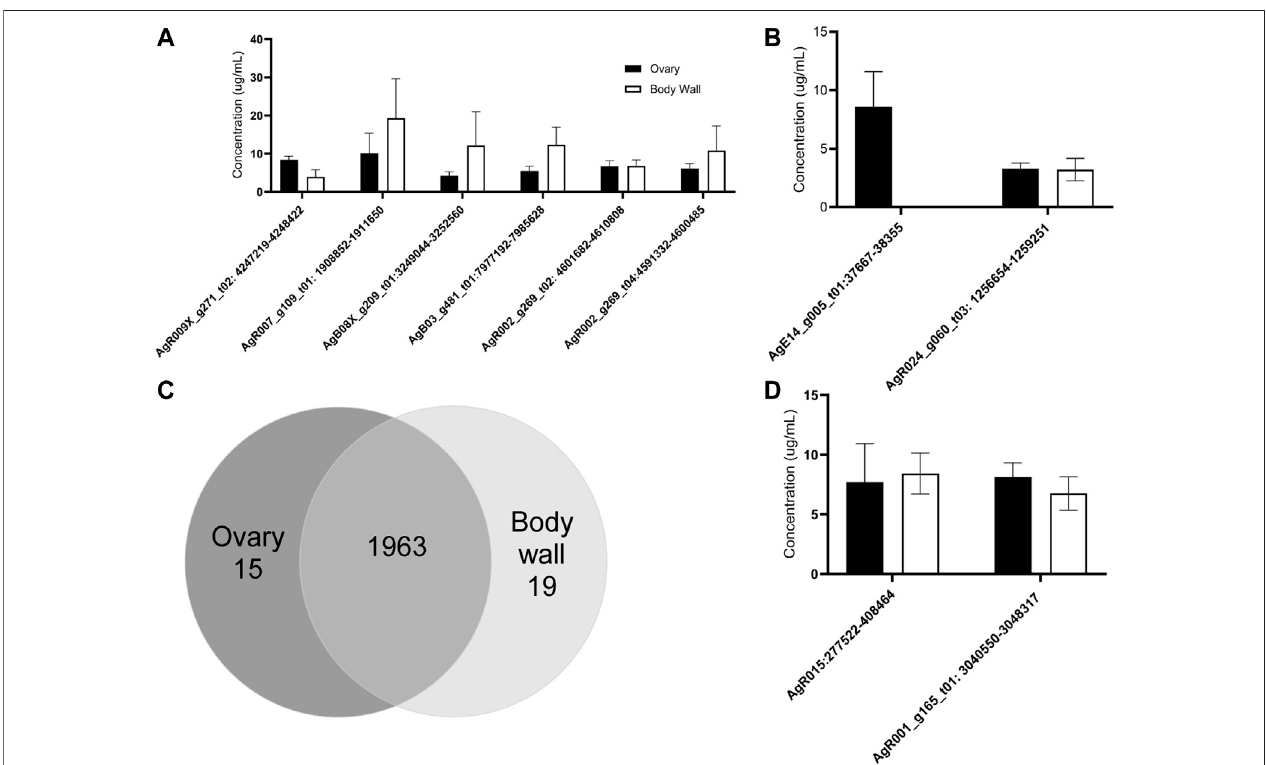
FIGURE 4 | RT-qPCR validates the expression of 10 of individual circRNAs in Ascaris suum ovary-enriched and body wall tissues. The tissue expression of circRNAs identi fi ed through sequencing was validated using RT-qPCR analysis. C t values were normalized using standard curve analysis with spike in RNA to calculate concentration of each circRNA. N = 4 (minimum), Mean ± SEM, p ≤ 0.05 being signi fi cant throughout. (A) The expression of six prioritized circRNAs was con fi rmed in ovary-enriched and body wall samples. These circRNAs were selected because of predicted expression in both tissue samples. Expression in both samples was con fi rmed, with no signi fi cant difference in expression levels between tissue samples. (B) The spatial expression of two circRNAs with predicted tissue speci fi c distribution in our circRNA sequencing datasets was analyzed. AgE14_g005_t01:37667 – 38355 was expected to be expressed in ovary-enriched tissue only and this was validated. Although AgR024_g060_t03:1256654 – 1259251 was expected to be expressed in body wall tissue only based on sequencing data, RT-qPCR analysis suggested a broader spatial distribution pattern (N = 3 minimum). (C) circRNA-seq identi fi ed 1,963 circRNAs in both tissue types, 15 were found only in the ovary- enriched samples while 19 were speci fi c to the body wall preparations. (D) We validated the expression of two atypically large circRNAs (over 5 kb) by RT-qPCR. Ampli fi cation using primers spanning back-splice junctions indicates these large RNA molecules are